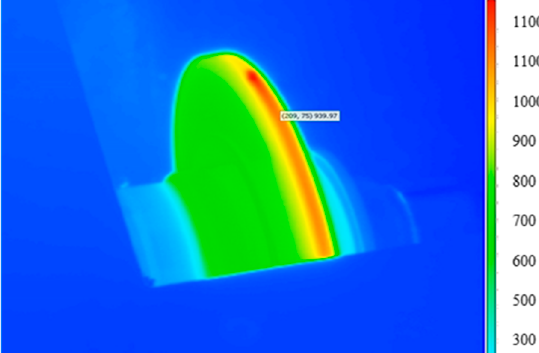
Figure 5. Typical temperature distribution during the heating process.